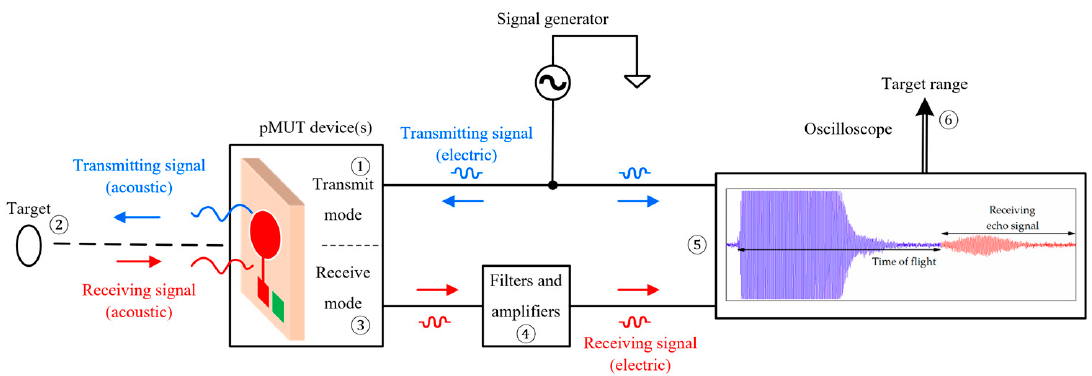
Figure 2. Block diagram of a pMUT rangefinder system. The signal shown in the oscilloscope is from [36] (Reproduced with permission from [36], Copyright 2018, MDPI AG).